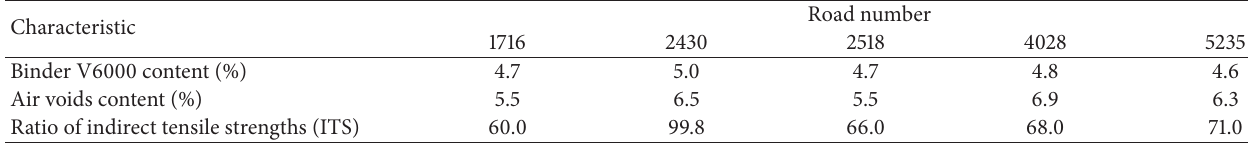
Table 2: Characteristics of soft asphalt (SA 16-d-V6000 type C).